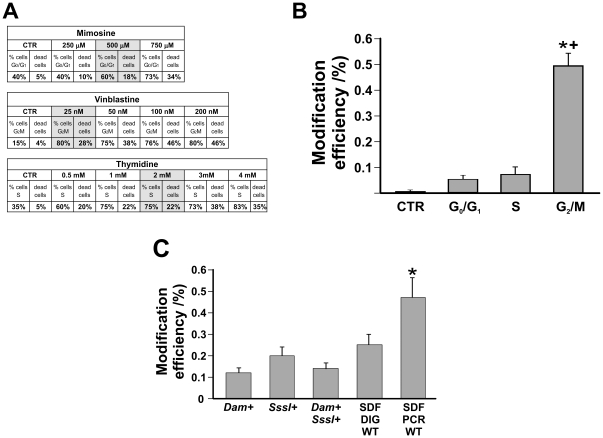
Modification efficiencies obtained testing different concentrations of mimosine, thymidine, vinblastine and SDFs with different superimposed methylation patterns on D1 cells.A) For each drug the concentration that gives the highest percentage of synchronized cells and the lowest cell death (highlighted in grey) was selected. B) Correction efficiencies after transfection in different cell cycle phases. A SDF homologous to mutated eGFP sequence was used as control (CTR). Gene modification efficiency was enhanced when cells are synchronized in G2/M phase (*p = 0.0001 respect to CTR and +p = 0.0001 respect to unsynchronized cells, Fig. S5). C) Differently in vitro methylated SDFs were tested to assess methylation involvement in gene modification efficiency. SDF-PCR-WT gave the highest efficiency of modification (*p resulted to be significant when compared to all treatments; specifically p = 0.002 respect to Dam+, p = 0.01 respect to SssI+, p = 0.008 respect to Dam+/SssI+, and p = 0.009 respect to SDF-DIG-WT). For representative FACS dot plots see Fig. S5 and S6.